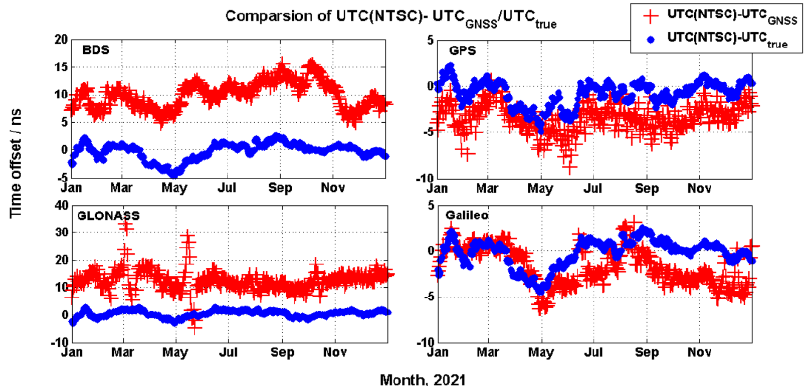
Figure 3. Comparison UTC(NTSC)-UTC GNSS with UTC(NTSC)-UTC true from GNSS.